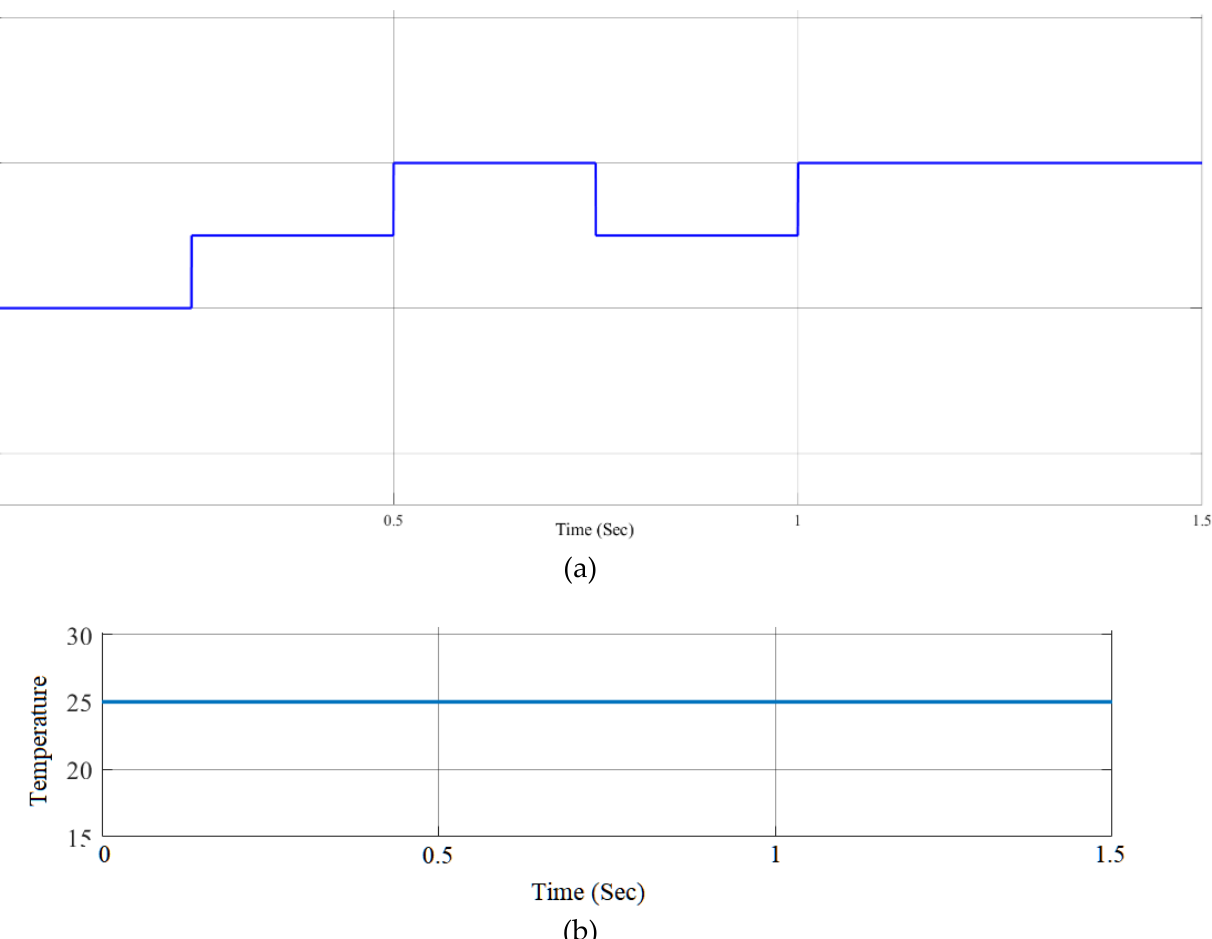
Figure 4. Performance of system ( a ) irradiationand ( b ) temperature. Figure 5 shows the PV indices such as solar insolation level; PV output power and proposed converter voltage. From the above Figure, it is also concluded that the energy obtained from PV is maximized with the help of the proposed converter and a stable power with less oscillations is obtained.